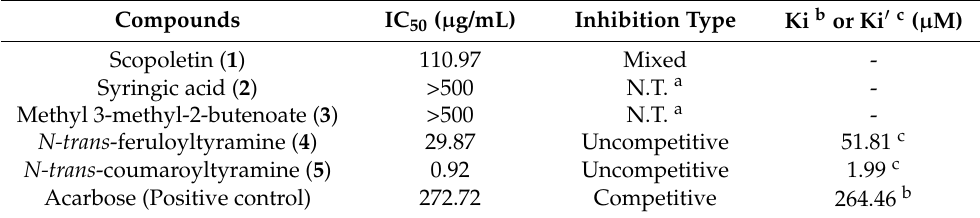
Table 1. Inhibitory activity of isolated compounds from N. racemosa on alpha-glucosidase. Compounds IC 50 ( µ g/mL) Inhibition